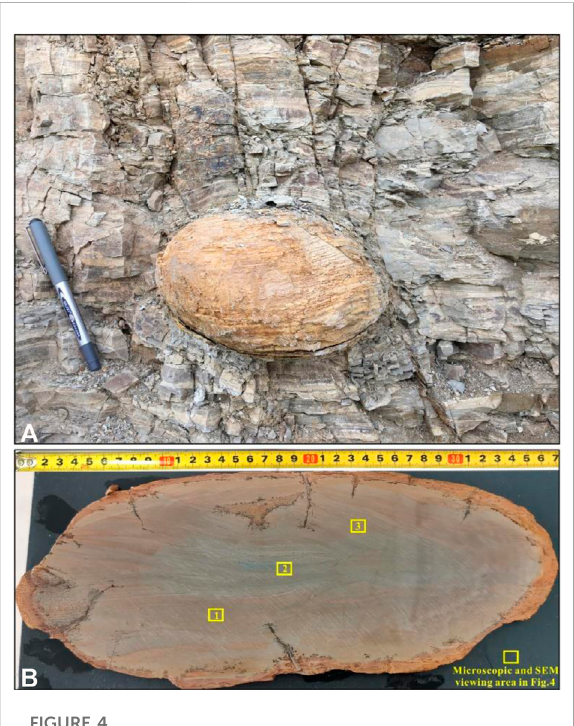
FIGURE 4 Images of concretions. (A) Field occurrence of the concretion; shale beddings surrounding the concretions were present; (B) Longitudinal pro fi le of the concretion. No obvious lamellae were observed in the main body of the concretions, except at the core. The concretion had a clear